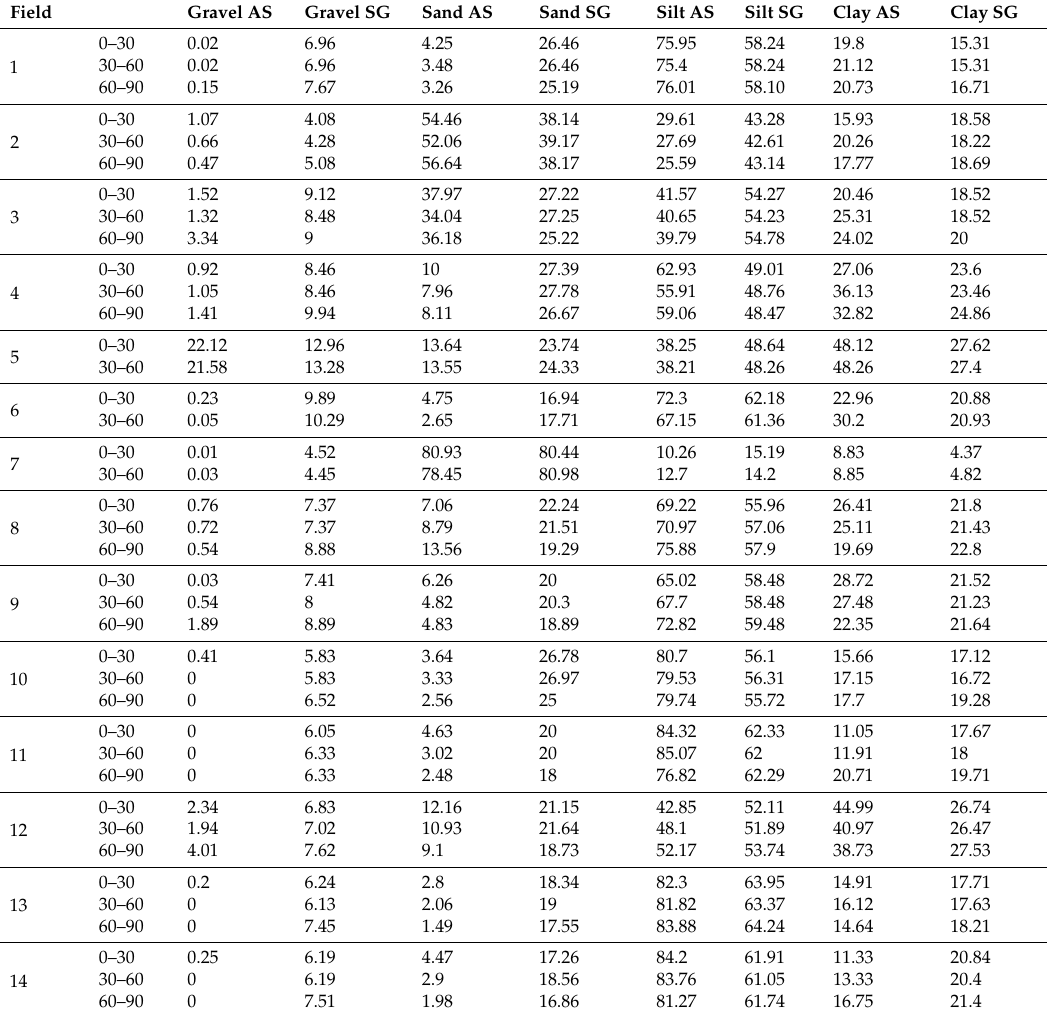
Table 1. Per-field mean values for di ff erent particle sizes (gravel, sand, silt, clay) and soil depths for soil samples analyzed in the lab ( = AS) and extracted from SoilGrids ( = SG) for sampling locations. All values expressed in mass fraction in